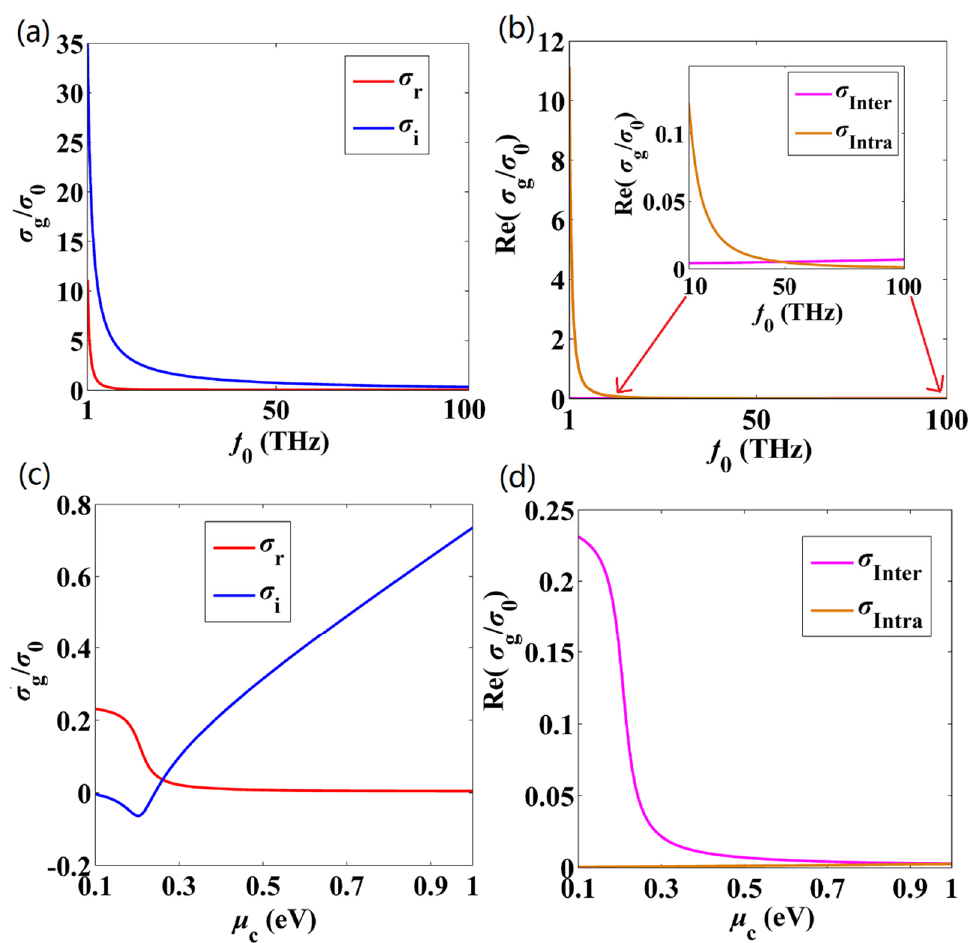
Figure 1. The graphene conductivity σ g , normalized by σ 0 = e 2 / ћ , as functions of the frequency and chemical potential, calculated from Equation (3). ( a ) Real and imaginary parts of σ g with respect to frequency. ( b ) Interband and intraband contributions of the real parts of the graphene conductivity with respect to frequency. ( c ) Real and imaginary parts of σ g with respect to μ c . ( d ) Interband and intraband contributions of the real parts of the graphene conductivity with respect to μ c . The chemical potential μ c is 0.5 eV for ( a ) and ( b ), and the frequency is 20 THz for ( c ) and ( d ). Other parameters are τ = 0.5 ps and T = 300 K.